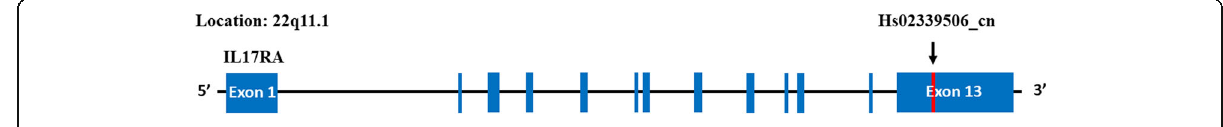
Fig. 1 The genetic structure of IL17RA gene and the position of Hs02339506_cm TaqMan assay containing primers and